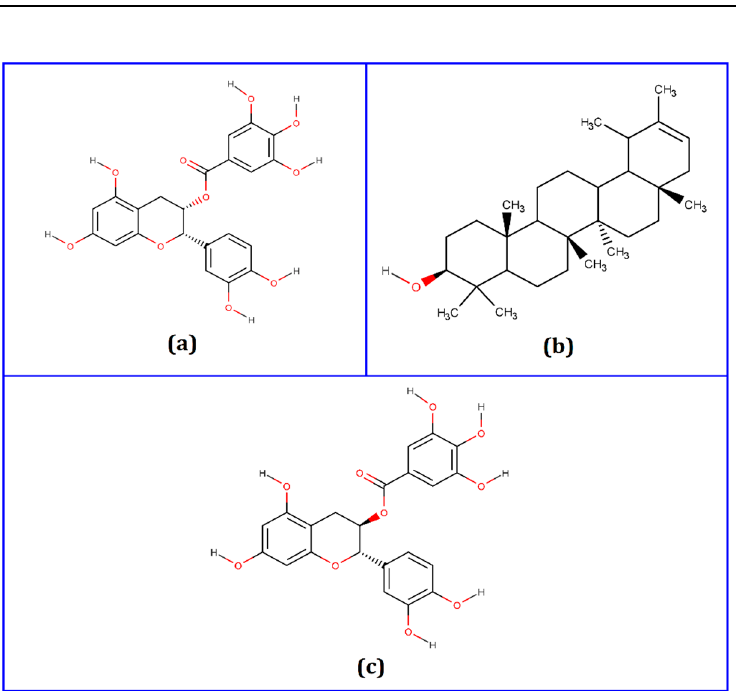
Figure 1. Two-dimensional (2D) chemical structures of ( a ) epicatechin-3-O-gallate, ( b ) psi-taraxasterol, and ( c ) catechin gallate. The structures were drawn using MarvinSketch software. The epicatechin-3-O-gallate–M pro complex formed three conventional hydrogen